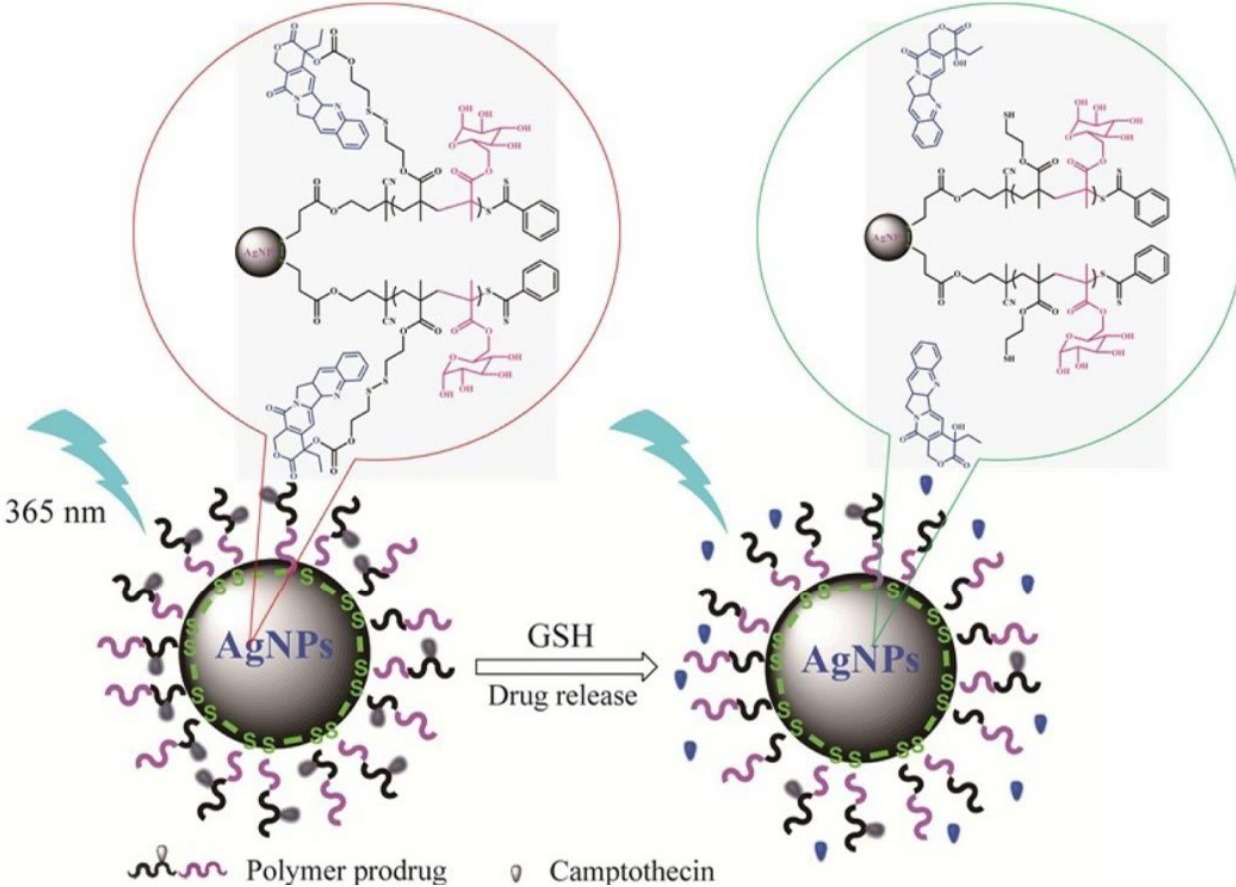
Figure 7. Representation of fluorescence “off” and “on” with the release of CPT from redox-responsive P(MACPTS-co- MAGP)@AgNPs nanoparticles. Reproduced from [88], with permission from © 2020